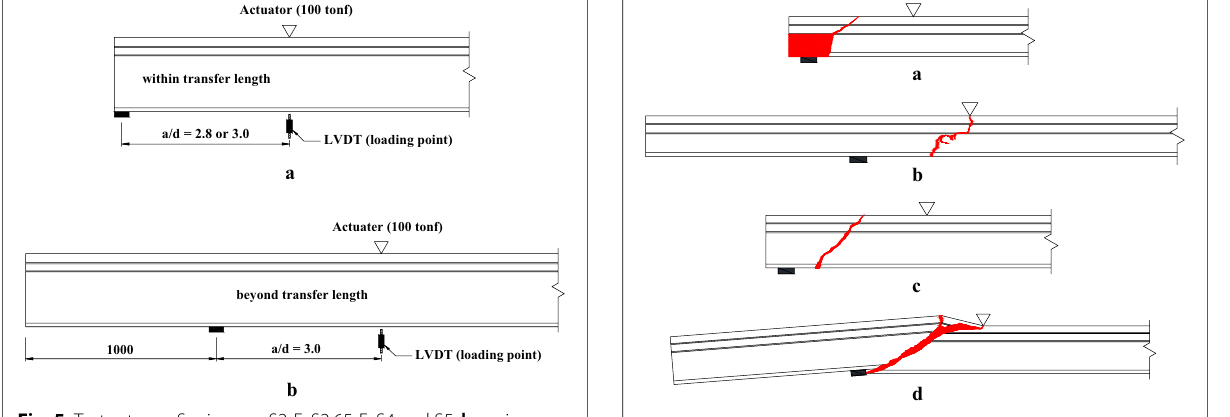
Fig. 6 Failure modes and crack patterns of specimens series S2 and S2.65. a Specimen S2‑E, b specimen S2‑F, c specimen S2.65‑E, d specimen